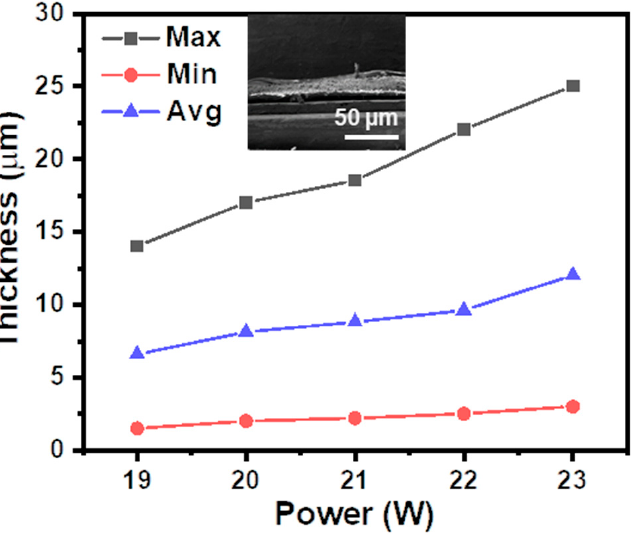
Figure 5. Effect of the laser power on the thickness of the obtained graphite on PI tape surface. Inset: cross-section SEM image of the obtained graphite on PI surface.